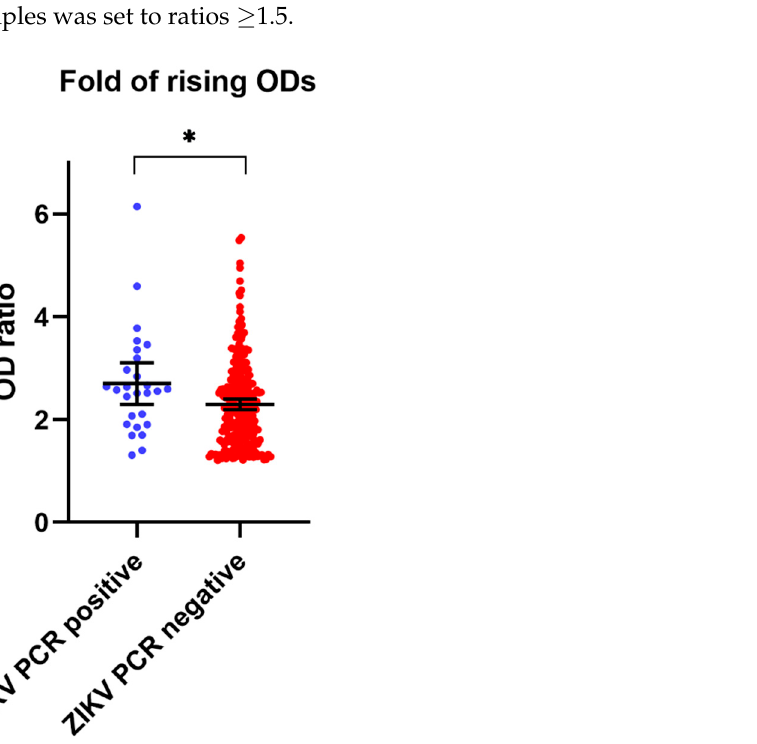
Figure 3. Rising OD folds between acute/convalescent serum samples. ZIKV NS1 IgG ELISA results of the analysis of 28 ZIKV (ZIKV RT-PCR confirmed) cases (blue) and 262 non-ZIKV infected persons (red). The OD ratio of the ZIKV group was statistically significantly different from that of the non-ZIKV group (* p = 0.022).